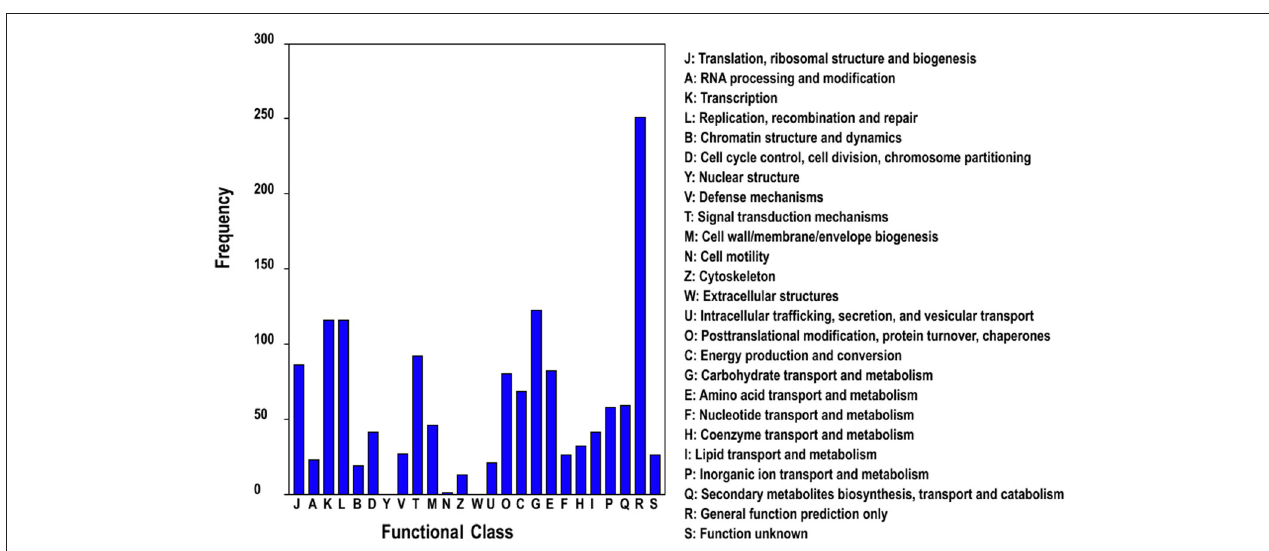
FIGURE 5 | COG classification of differentially expressed genes of different ploidy plants of Dendrocalamus latiflorus.